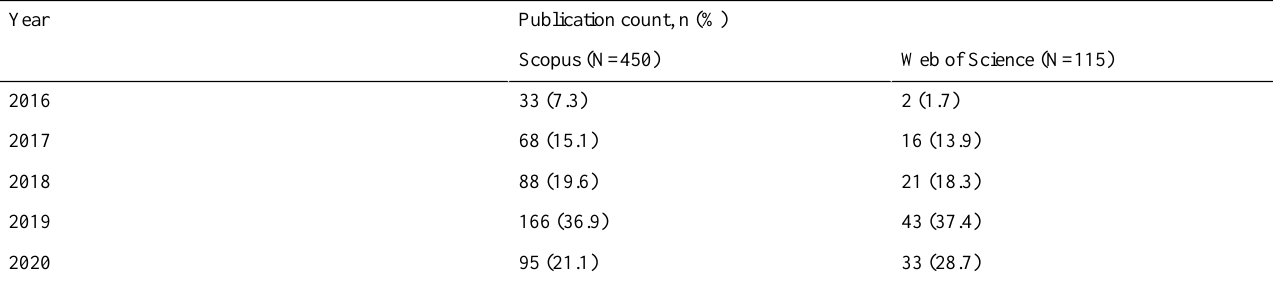
Table 1. Number of publications per year.